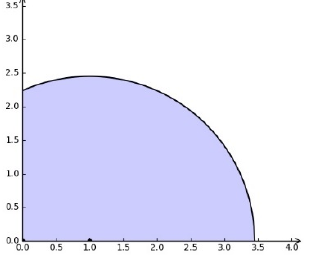
Figure 4. The area of